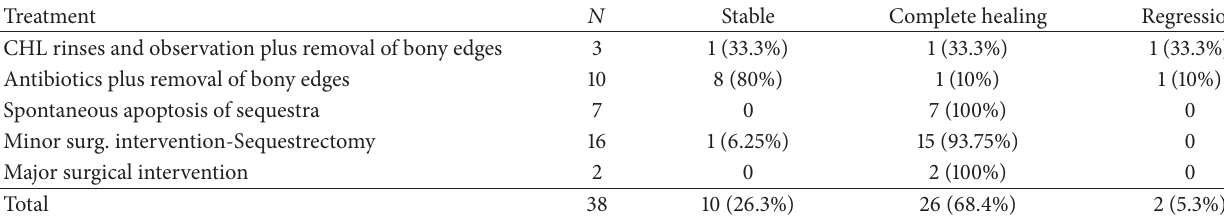
Table 3: Results of ONJ